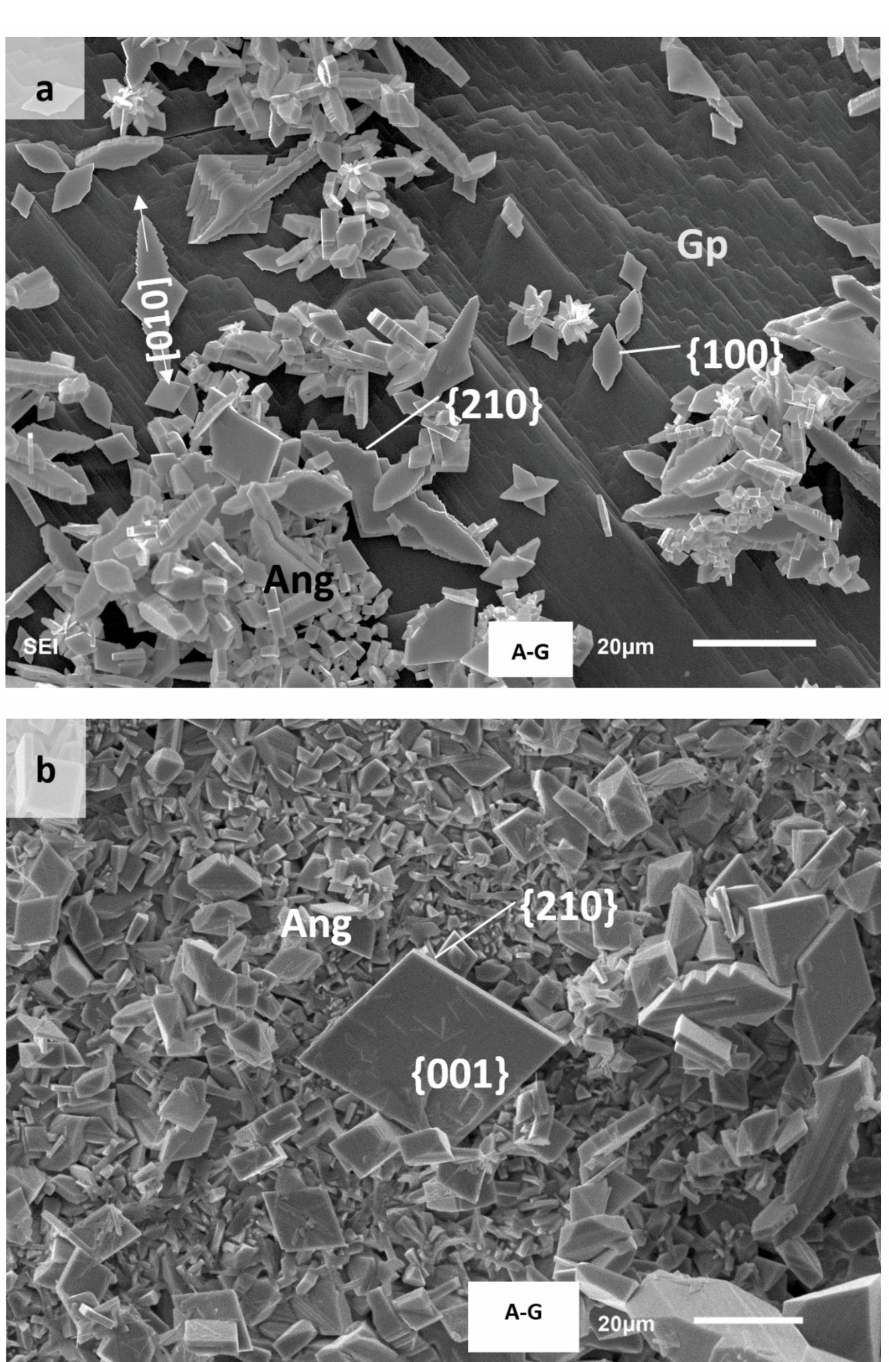
Figure 4. SEM micrographs of anglesite (Ang) formed on gypsum crystals (Gp) interacting with aqueous solutions with [Pb] i = 10 mM. ( a ) After 5 min interaction, the development of dissolution features as well as the growth of anglesite crystals are observed on gypsum surfaces. Anglesite crystals initially growth elongated along the b-axis with a habit defined by flat surfaces that belong to the pinacoid {001}, the rhombic prism {210}, and stepped surfaces roughly parallel to (100). ( b ) After 24 h, gypsum surfaces become fully carpeted by anglesite crystals that show a habit dominated by platy faces belonging to the pinacoid {001} and smaller {210}